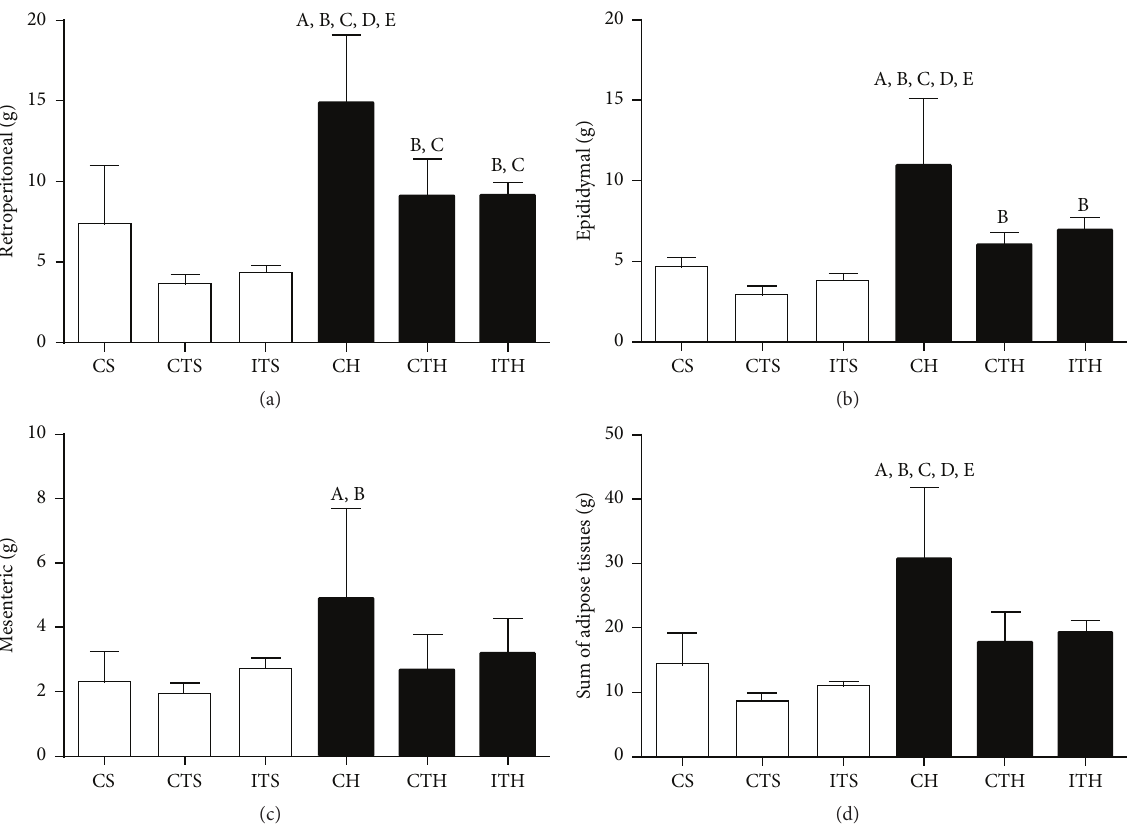
Figure 1: Absolute values of (a) retroperitoneal tissue, (b) epididymal tissue, (c) mesenteric tissue, and (d) sum of adipose tissues. CS: control standarddiet;CTS:continuoustrainingstandarddiet;ITS:intervaltrainingstandarddiet;CH:controlhigh-fatdiet;CTH:continuoustraining high-fat diet; ITH: interval training high-fat diet. A 𝑝 < 0.05 compared to CS; B 𝑝 < 0.05 compared to CTS; C 𝑝 < 0.05 compared to ITS; D 𝑝 < 0.05 compared to CTH; E 𝑝 < 0.05 compared to ITH. Mesenteric values were compared by Kruskal-Wallis test. Values are means ±